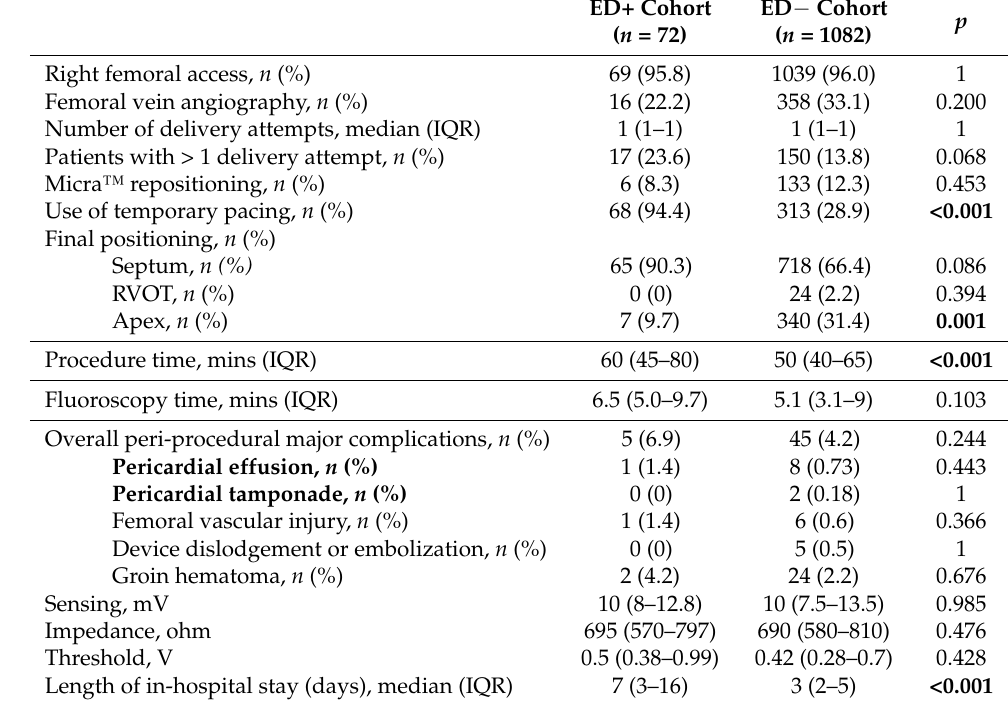
Table 3. Peri-procedural characteristics.